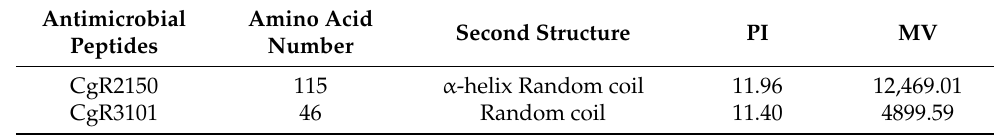
Table 3. Bioinformatics prediction of antimicrobial peptides CgR2150 and CgR3101.